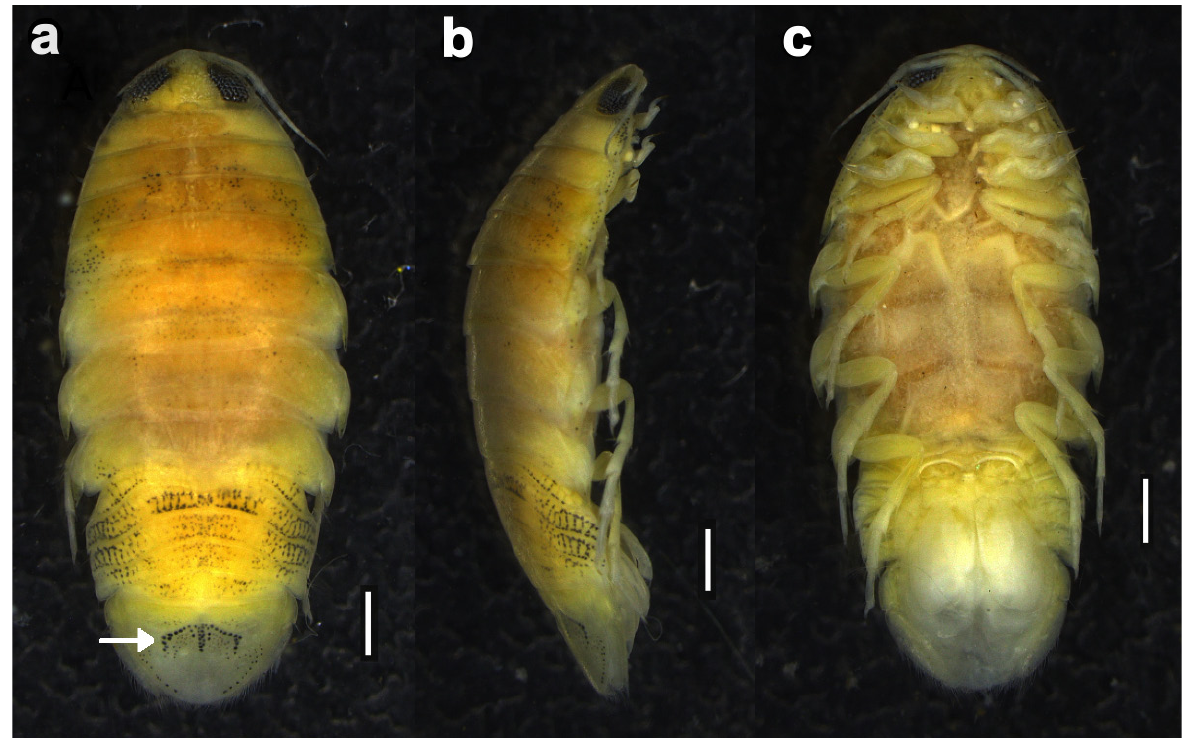
Figure 2 - Rocinela signata from the gills of Pseudupeneus maculatus , Northeastern Brazil. a - dorsal view; b - lateral view; c - ventral view. The arrow indicates the pigmented inverted W on the pleotelson. Scale bar: 1